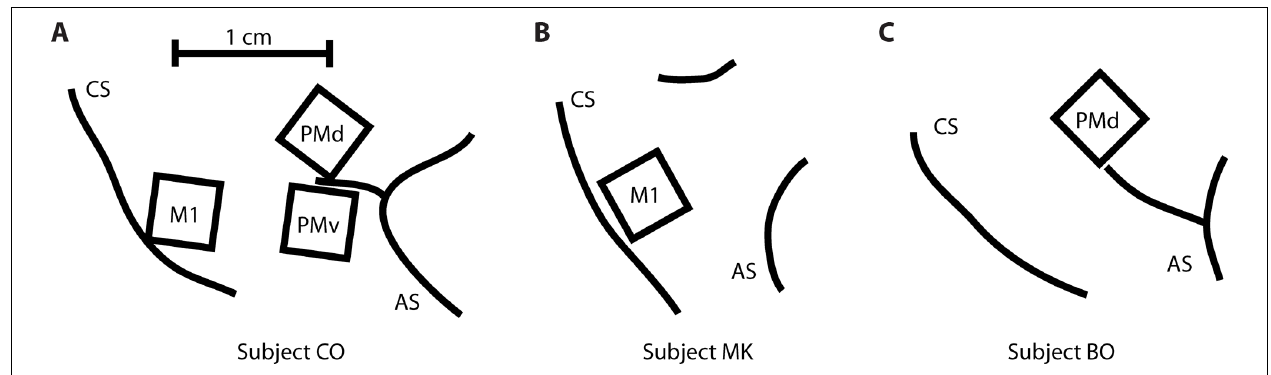
FIGURE 2 | Location of the five multi-electrode arrays relative to the central sulcus (CS) and the arcuate sulcus (AS). (A) Subject CO had arrays in primary motor cortex (MI), dorsal premotor cortex (PMd), and ventral premotor cortex (PMv). (B) Subject MK had one array in MI. (C) Subject BO had one array in PMd.